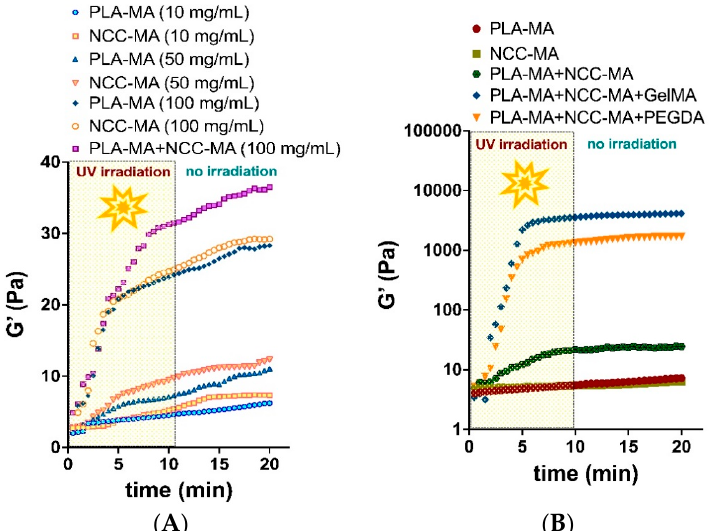
Figure 8. Results of rheological studies on crosslinking kinetics: ( A ) effect of particle concentration; ( B ) effect of cross-linkers (PEGDA and GelMA) on particle cross-linkers. Shown is G’ (storage modulus) evolution with time; G” (loss modulus) is not shown for the purpose of clarity. In all samples G’ > G” after exposure to UV, indicating a well-developed and solid polymer network. Samples were measured at 25 °C and were exposed to UV intensity of 1.2 J/cm 2 . The curves shown are representative ones of three measurements.